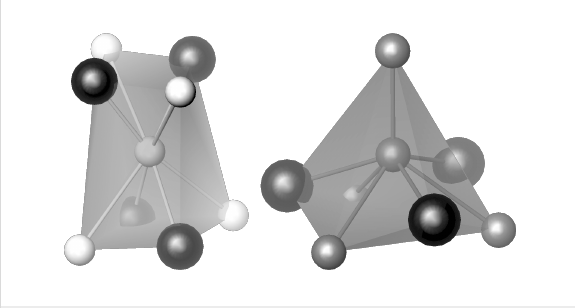
Figure 4: Coordination polyhedra of E1 (left) and As2 (right) sites in the crystal structure of Re 3 As 7 − x In x .